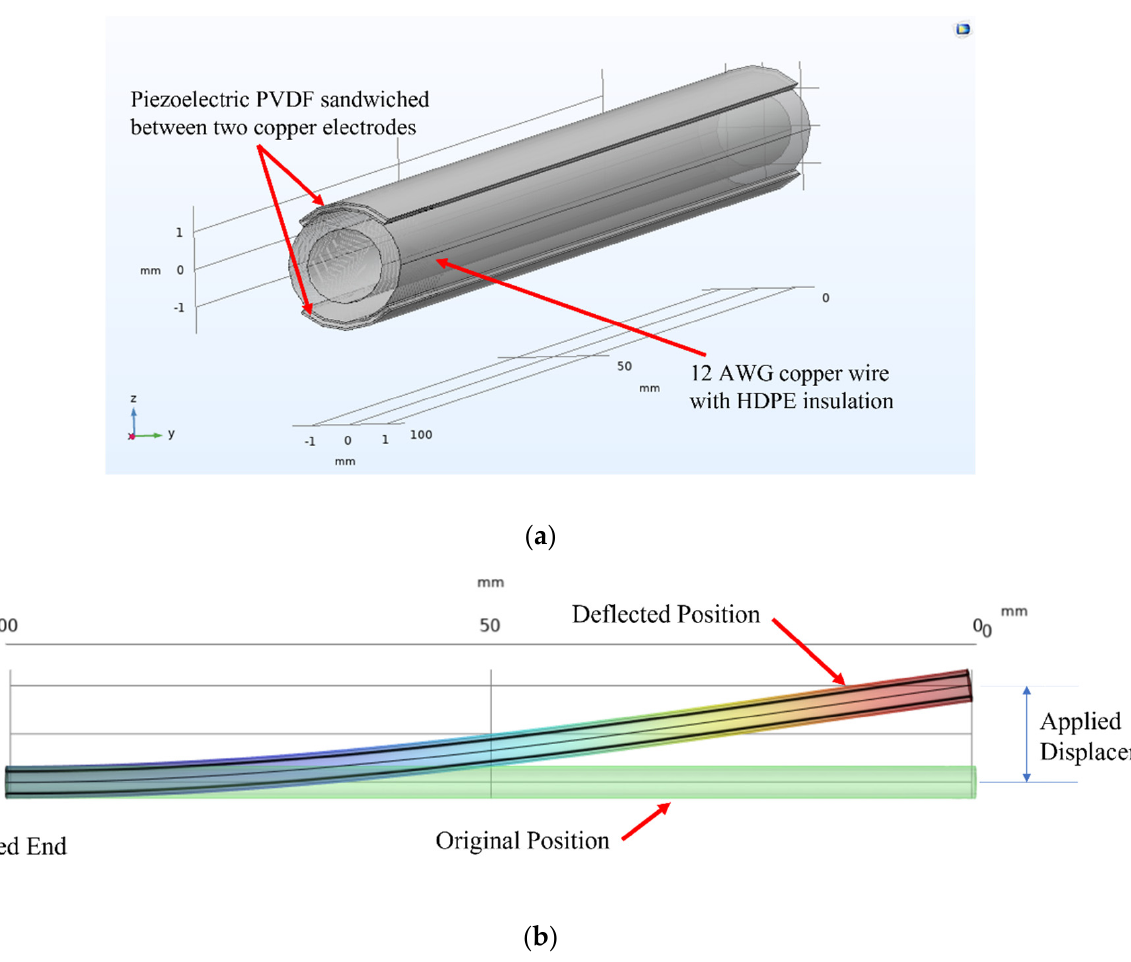
Figure 4. Piezoelectric bilayer energy harvester used in finite element analysis. ( a ) Model of piezoelectric energy harvester. ( b ) Boundary conditions of piezoelectric energy harvester.